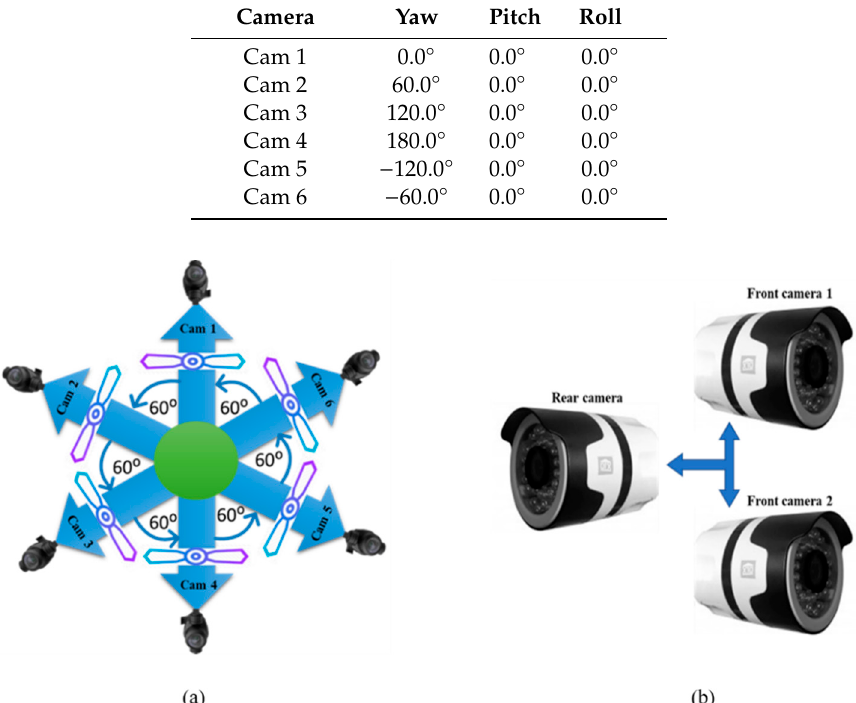
Figure 3. The proposed camera setup for panorama generation: ( a ) camera step for mono panorama generation, ( b ) camera setup for stereo panorama generation.